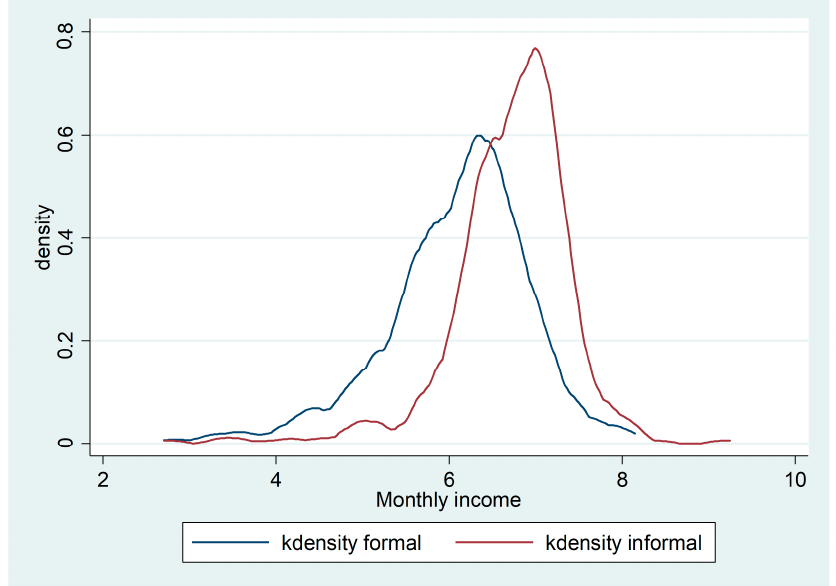
Figure 1. Densities of monthly log income for the three countries. Source: Sahwa dataset using Stata.